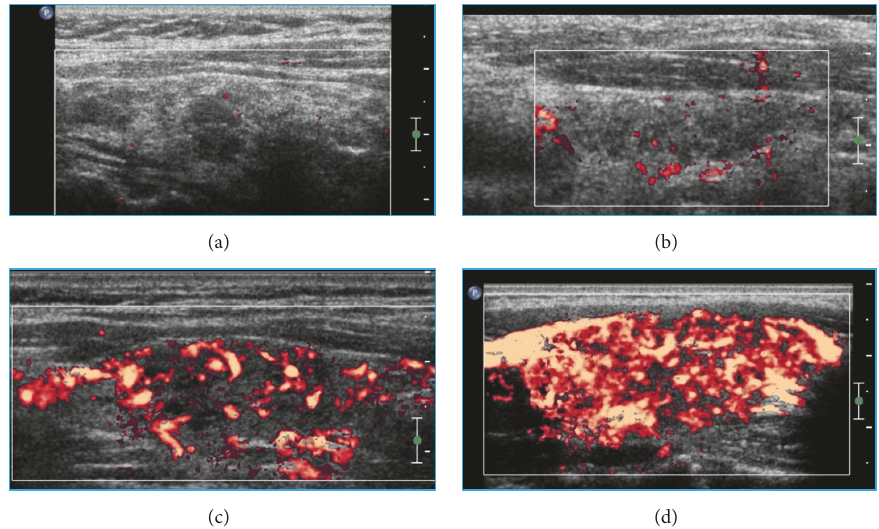
Figure 1: Color Doppler images. Parts (a), (b), (c), and (d) correspond to vascularization patterns 0, I, II, and III of the thyroid parenchyma, respectively.